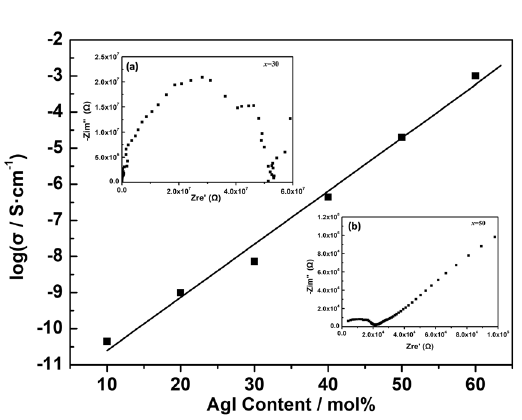
Figure 4. Raman spectra of glass samples in Series A (100– x ) (0.2Ga 2 S 3 -0.8Sb 2 S 3 ) − x AgI: where x = 10, 30, and 60, respectively.